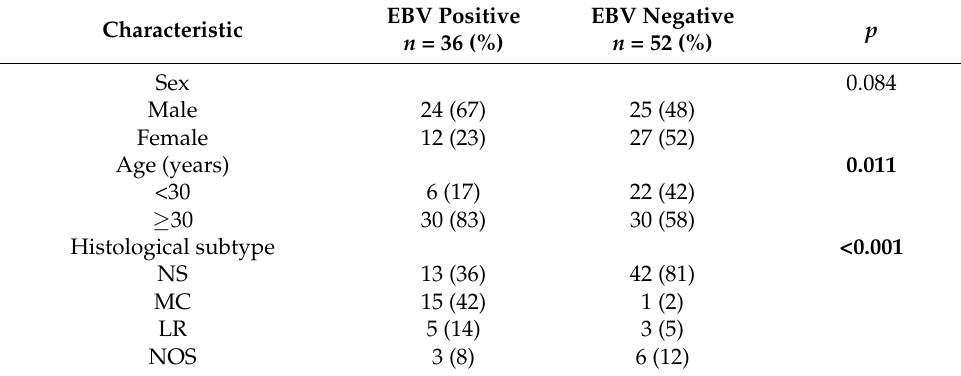
Table 2. Comparison between clinical, histopathological and prognostic variables adjusted for EBV infection